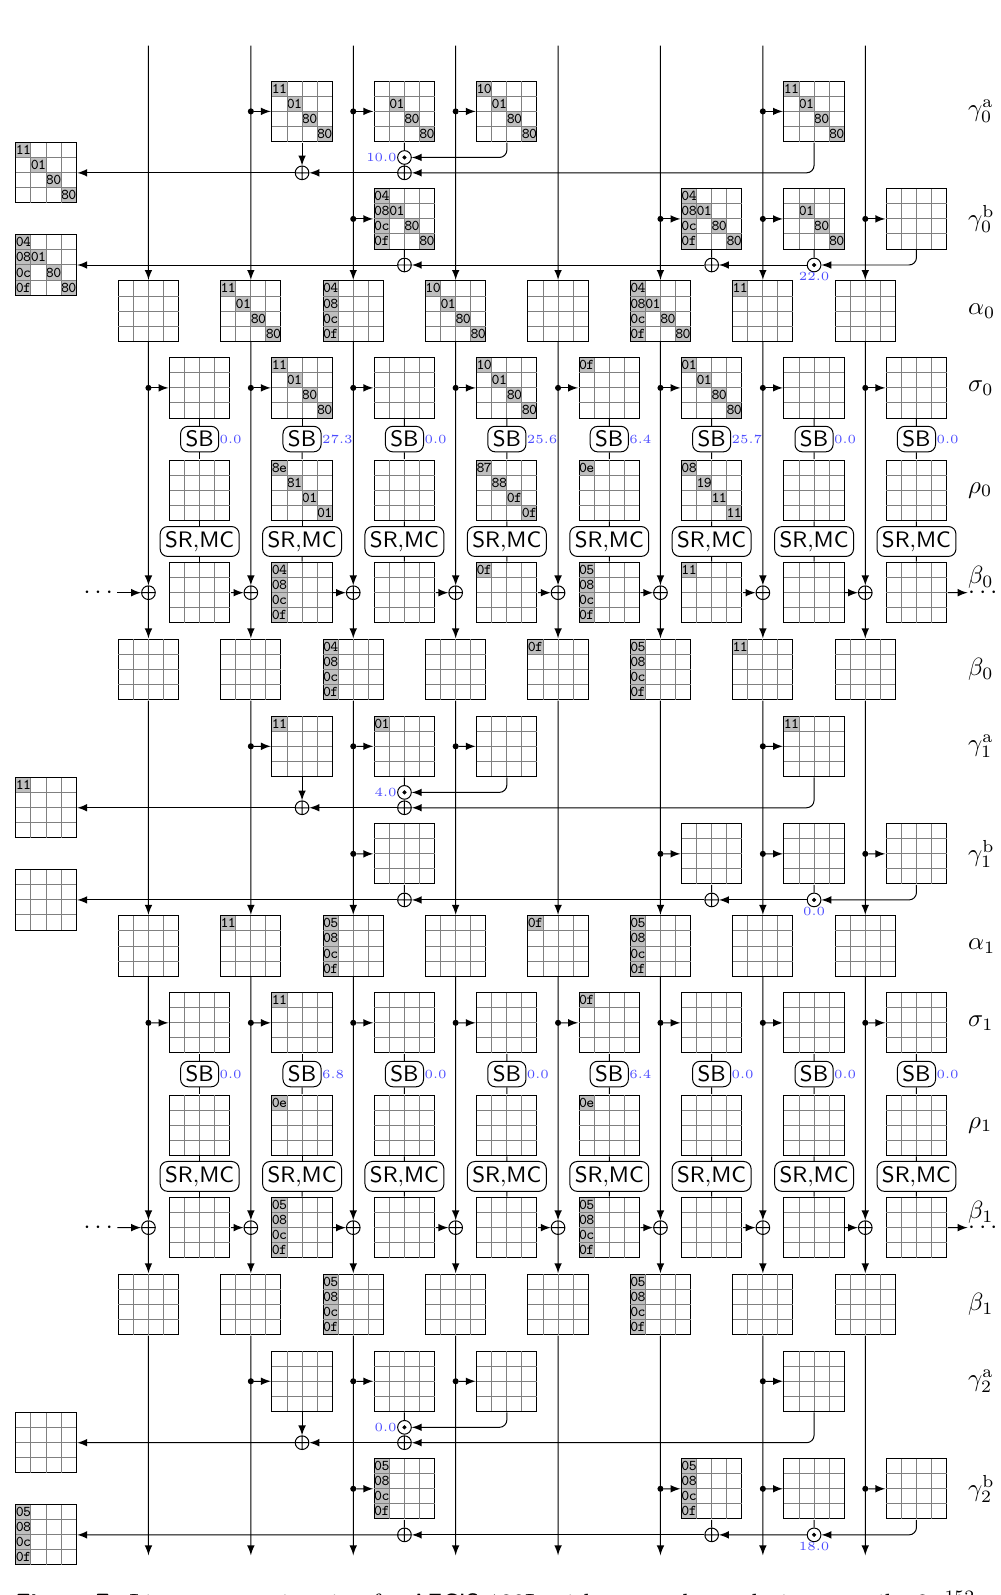
Figure 7: Linear approximation for AEGIS -128L with squared correlation contrib. 2 − 152